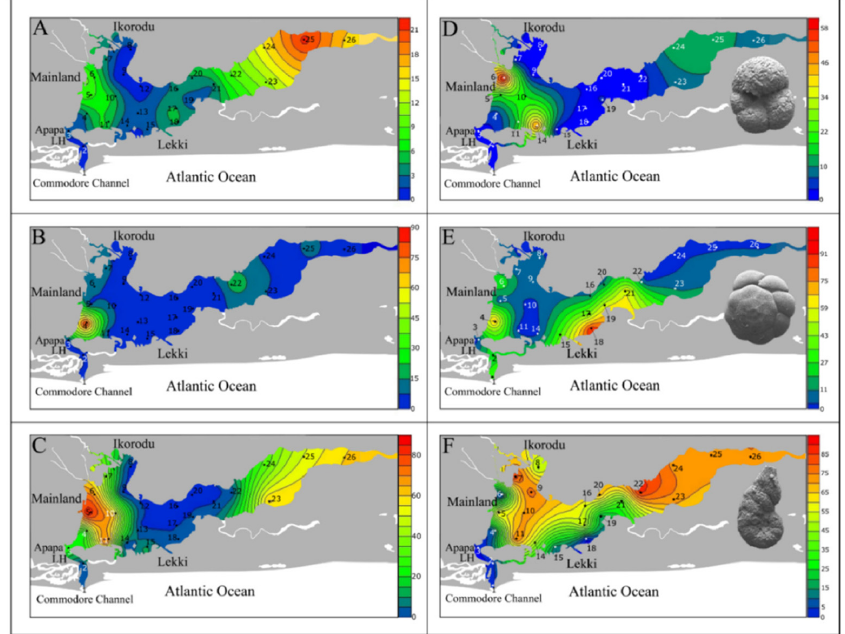
Figure 2. Spatial distribution and % concentration of ( A ) Total organic carbon (%), ( B ) Carbonate (%),